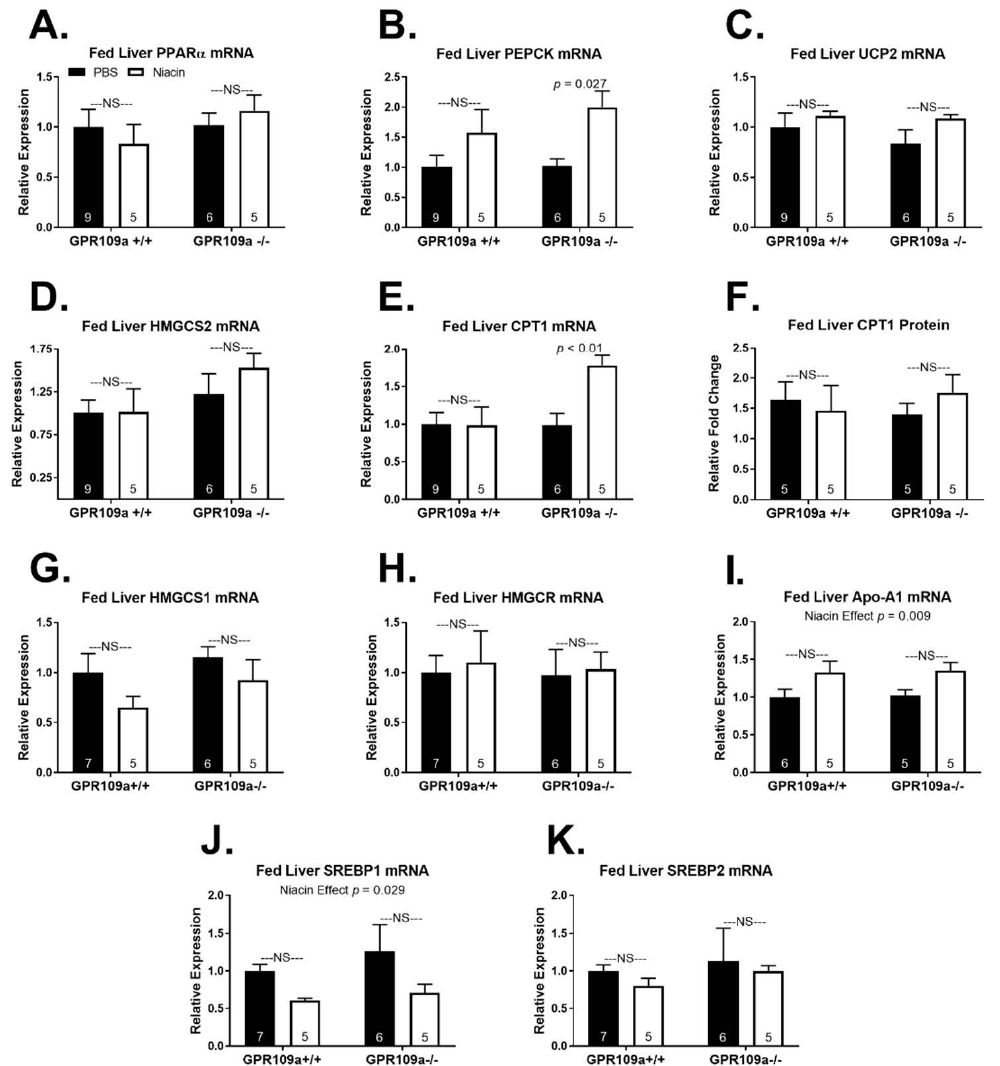
Figure 3. Effect of niacin on hepatic gene expression in fed GPR109a +/+ and − / − mice. Hepatic ( A ) PPAR α mRNA expression, ( B ) PEPCK mRNA expression, ( C ) UCP2 mRNA expression, ( D ) HMGCS2 mRNA expression, ( E ) CPT1 mRNA expression, ( F ) CPT1 protein expression, ( G ) HMGCS1 mRNA expression, ( H ) HMGCR mRNA expression, ( I ) Apo-A1 mRNA expression, ( J ) SREBP1 mRNA expression, and ( K ) SREBP2 mRNA expression. Direct comparisons were made between injection treatments within genotypes. NS = non-significant; p > 0.05; PBS = phosphate-buffered saline. Numbers inside bars denote the n per